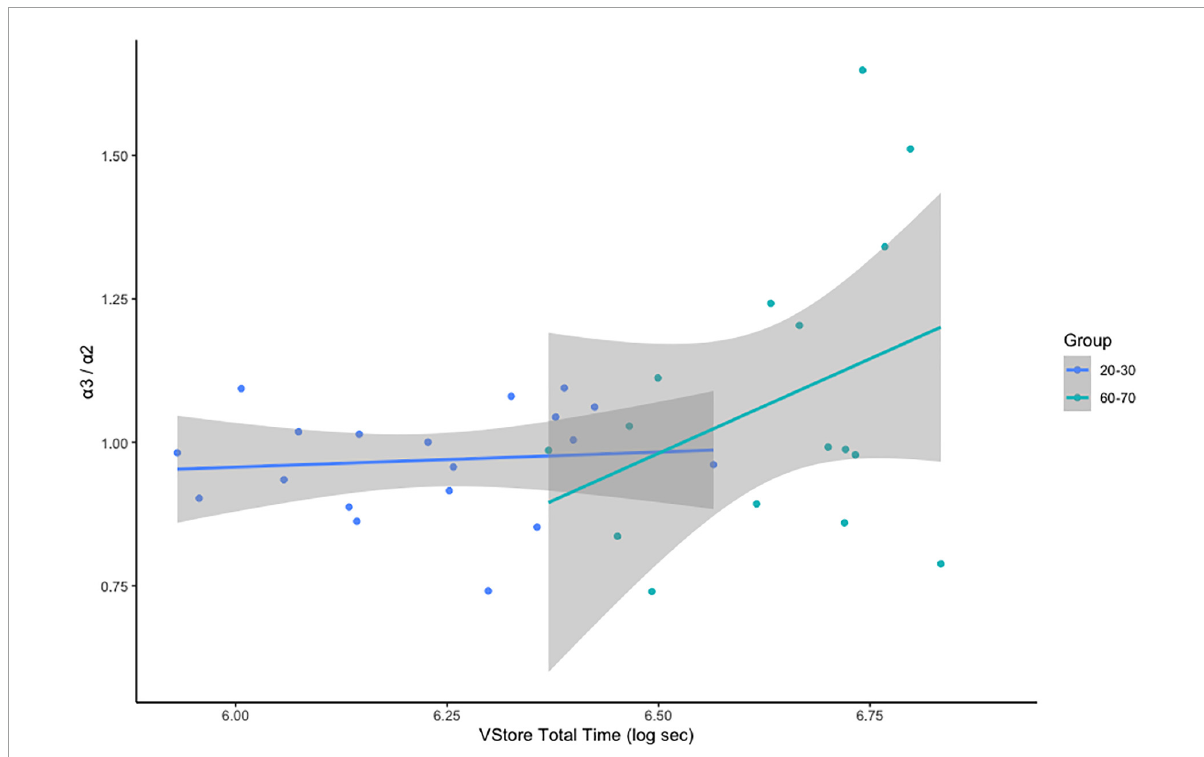
FIGURE3 Correlations between VStore Total Time and α 3/ α 2 ratios stratified by age group.